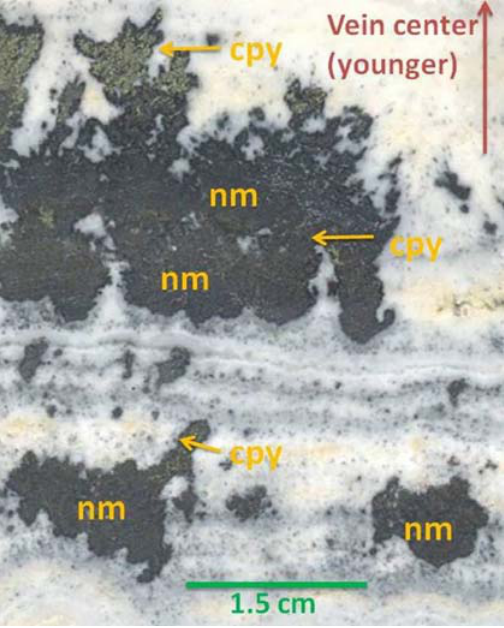
Figure 6. Photograph of another sample of bonanza Au-Ag ore from the Bell vein, Buckskin National deposit, showing three discrete episodes where chalcopyrite (cpy) is a major ore mineral. In all three examples here, chalcopyrite is deposited on the outer edge of the naumannite (nm) dendrites, although that is more difficult to see in the middle chalcopyrite-depositing event as two different naumannite bands are in close proximity.